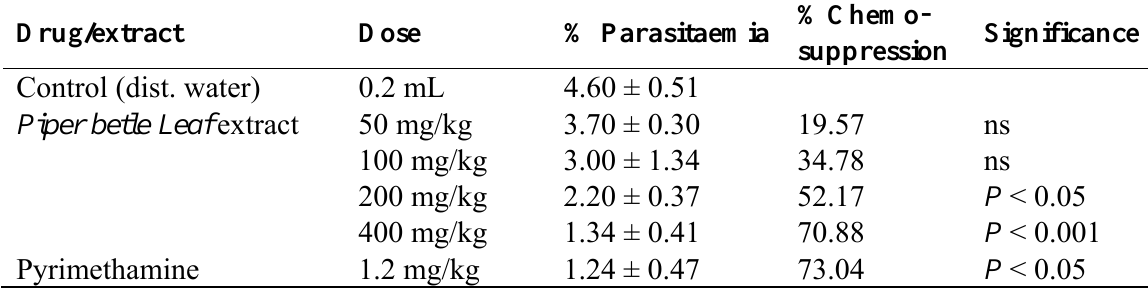
Table 4. Effect of the methanol extract of Piper betle on residual malaria infection.